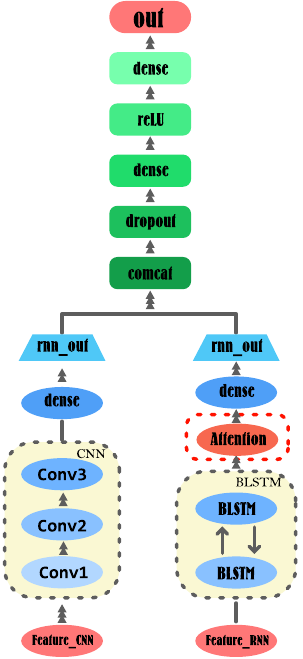
Figure 7. AttnBiLSTM-CNN